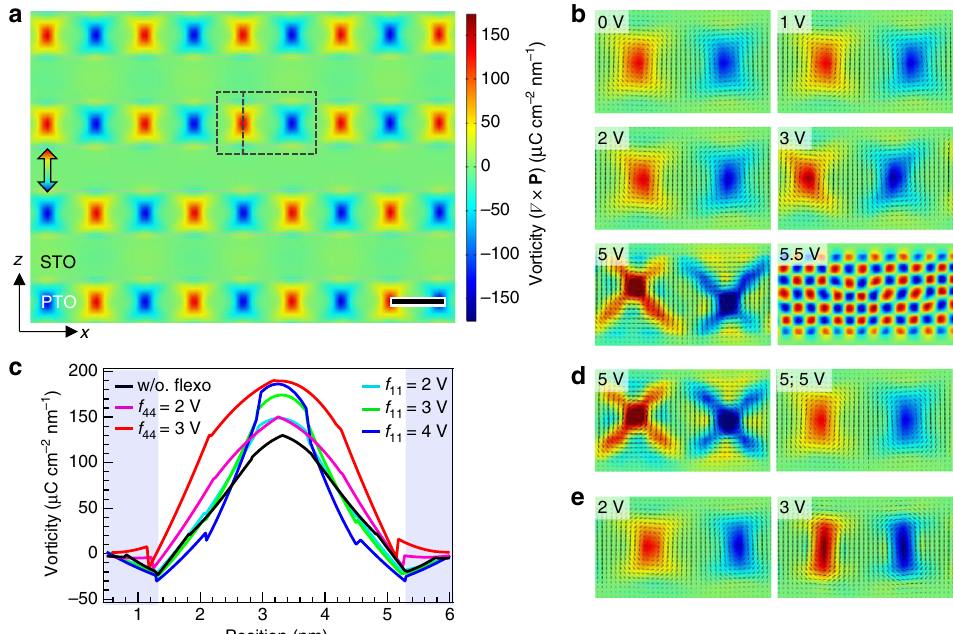
Fig. 2 Modeling the fl exocoupling effects of PbTiO 3 . a Simulated vortex patterns represented by the vorticity calculated from the polarization vector fi eld. A vortex/anti-vortex pair region marked by the dashed line is chosen to illustrate the fl excoupling effects in what follows. The double-arrow symbol indicates an anti-phase boundary. Scale bar, 5 nm. b , d , e The evolution of the vortex pattern under varying longitudinal b , transverse d , and shear e fl exocoupling of the PTO layers. In d , “ 5; 5 V ” denotes the case of f 11 PTO = f 12 PTO = 5.5 V; all others have only one nonzero f variable. The same color scale is used here as that for a , except for f 11 PTO = 5.5 V in b whose range is from − 1,000 to 1,000 ( μ C cm − 2 nm − 1 ). The polarization vectors (arrows) are overlaid on the vorticity images. c Section line pro fi les of the vorticity along the line marked on a (in-plane shift corrected), under selected fl exocoupling conditions. The lightly blue-shaded region corresponds to STO